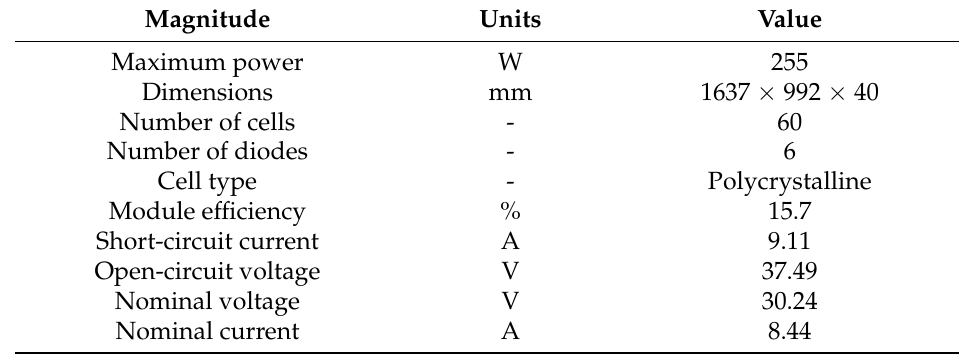
Figure 3. SR-P660255 bypass diode configuration. Table 1. Sunrise SR-660255